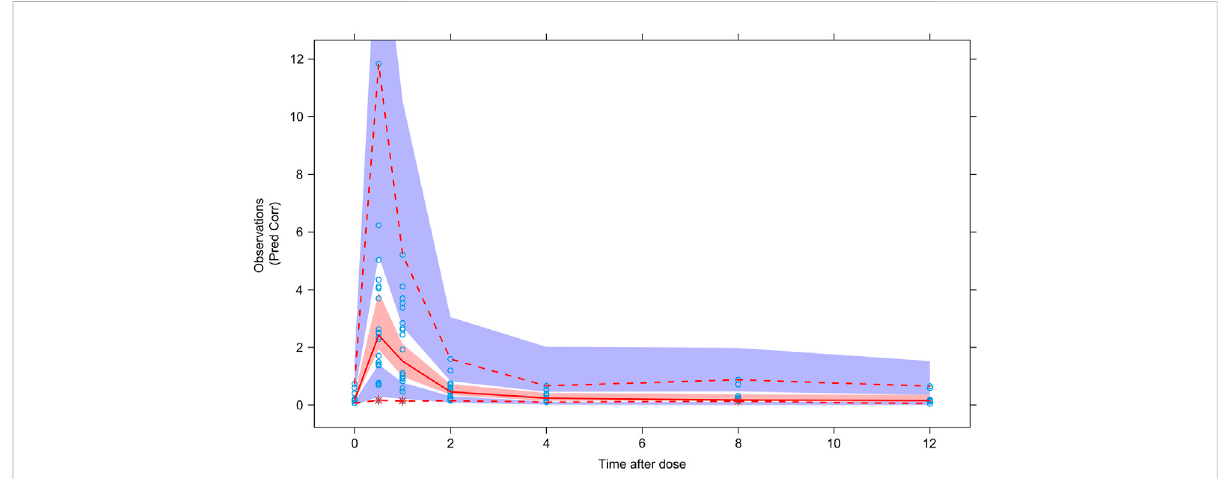
FIGURE 4 Visual predictivecheck ofthe fi nal model. Circles represent observations. Red solid line standsfor themedian ofsimulated concentrations, and red imaginary lines stand for the 90% prediction interval (PI) (5%, 95%) of the predictive MPA concentrations. Shaded areas represent the 95% con fi dence interval (CI) for each line.